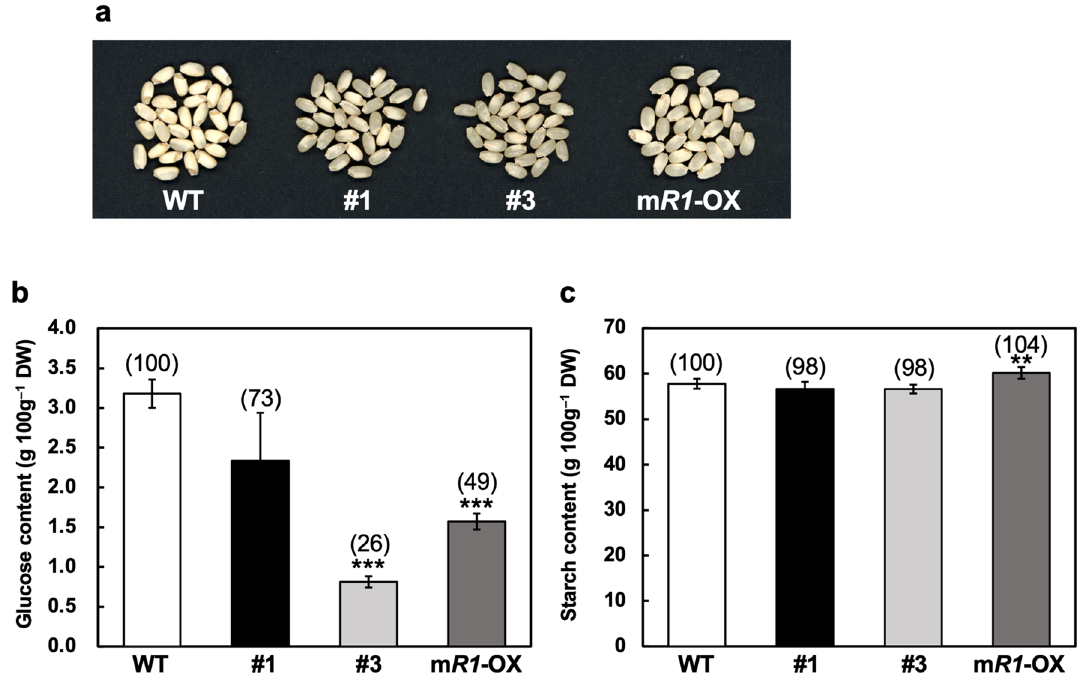
Figure 6. Differences in the rice grains’ chalky appearance and glucose as well as starch contents of plants grown in a growth chamber under normal conditions. ( a ) Rice grains of the wild-type (WT), R1 -Cas #1 and #3, and m RDD1 -OX plants (m R1 -OX). ( b , c ) Glucose ( b ) and starch contents ( c ) of the rice grains of the WT, R1 -Cas #1 and #3, and m RDD1 -OX plants (m R1 -OX). Data are presented as the average ± standard error of the mean ( n = 5). Asterisks indicate significant differences relative to the WT plants based on the Student’s t -test (** p < 0.01 and *** p < 0.001). Values relative to those of WT as 100 are shown in